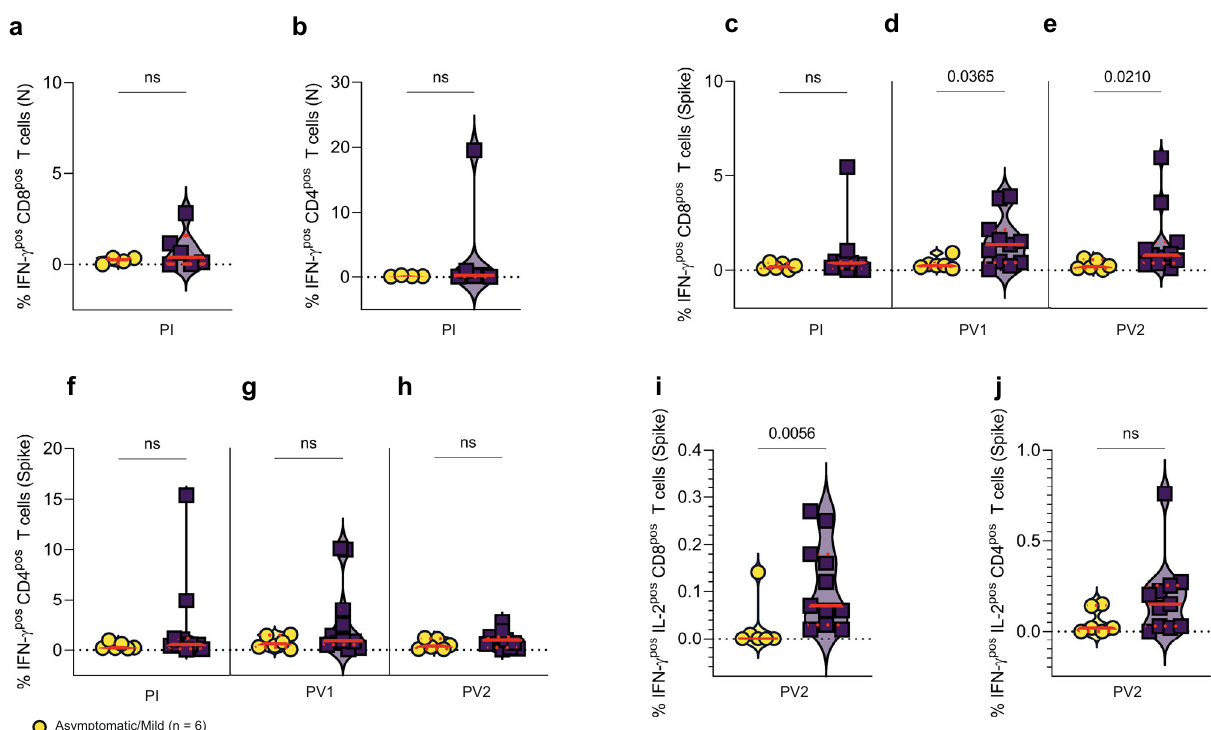
Fig. 7 Comparison between asymptomatic/mild and moderate/severe infection groups of effector T-cell responses to SARS-CoV-2 N and S peptides following 7-day in vitro stimulation. a CD8 + T cell and b CD4 + T cell IFN- γ responses to N peptide restimulation from asymptomatic/mild ( n = 4) and moderate/severe ( n = 6) samples collected after infection were measured by fl ow cytometry after 7-day culture followed by 5 h restimulation. Similar comparisons of IFN- γ + responses following S peptide restimulation were made for asymptomatic/mild ( n = 6) and moderate/severe ( n = 11) samples obtained c after infection, d PV1 and e PV2 for CD8 + T cells and f after infection, g PV1 and h PV2 for CD4 + T cells. Polyfunctional IFN- γ + /IL-2 + i CD8 + and j CD4 + T cell responses to S peptide restimulation are shown for asymptomatic/mild ( n = 6) and moderate/severe ( n = 11) groups. P values, calculated using the Mann – Whitney U -test, are shown above lines spanning the groups compared. Red lines bisecting groups represent median (solid) with IQR